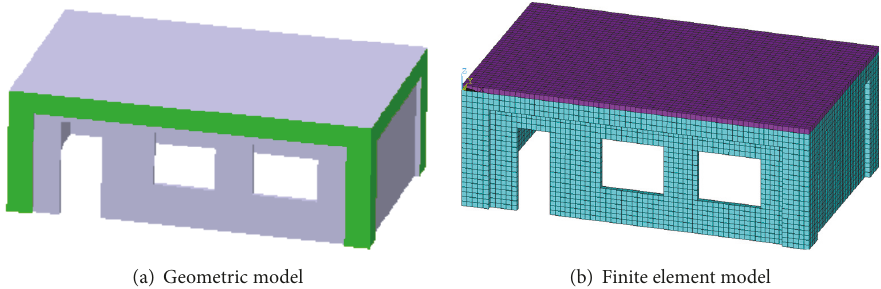
Figure 1: Geometric model and finite element model of the masonry